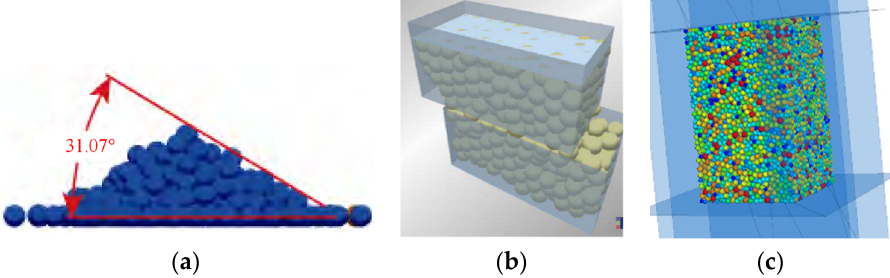
Figure 2. Typical calibration method for soil model parameters. ( a ) Repose angle test [29]; ( b ) Direct shear test [20]; ( c ) Triaxial compression test.